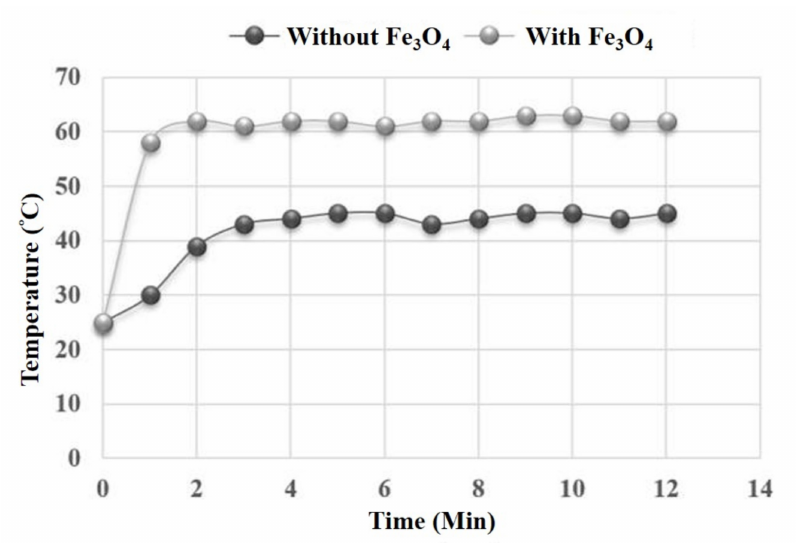
Figure 4. The temperature curve changes during continuous testing at a microwave power of 560 W with or without Fe 3 O 4 co-catalyst. The reaction was carried out in triplicate, and the average is shown in the figure.